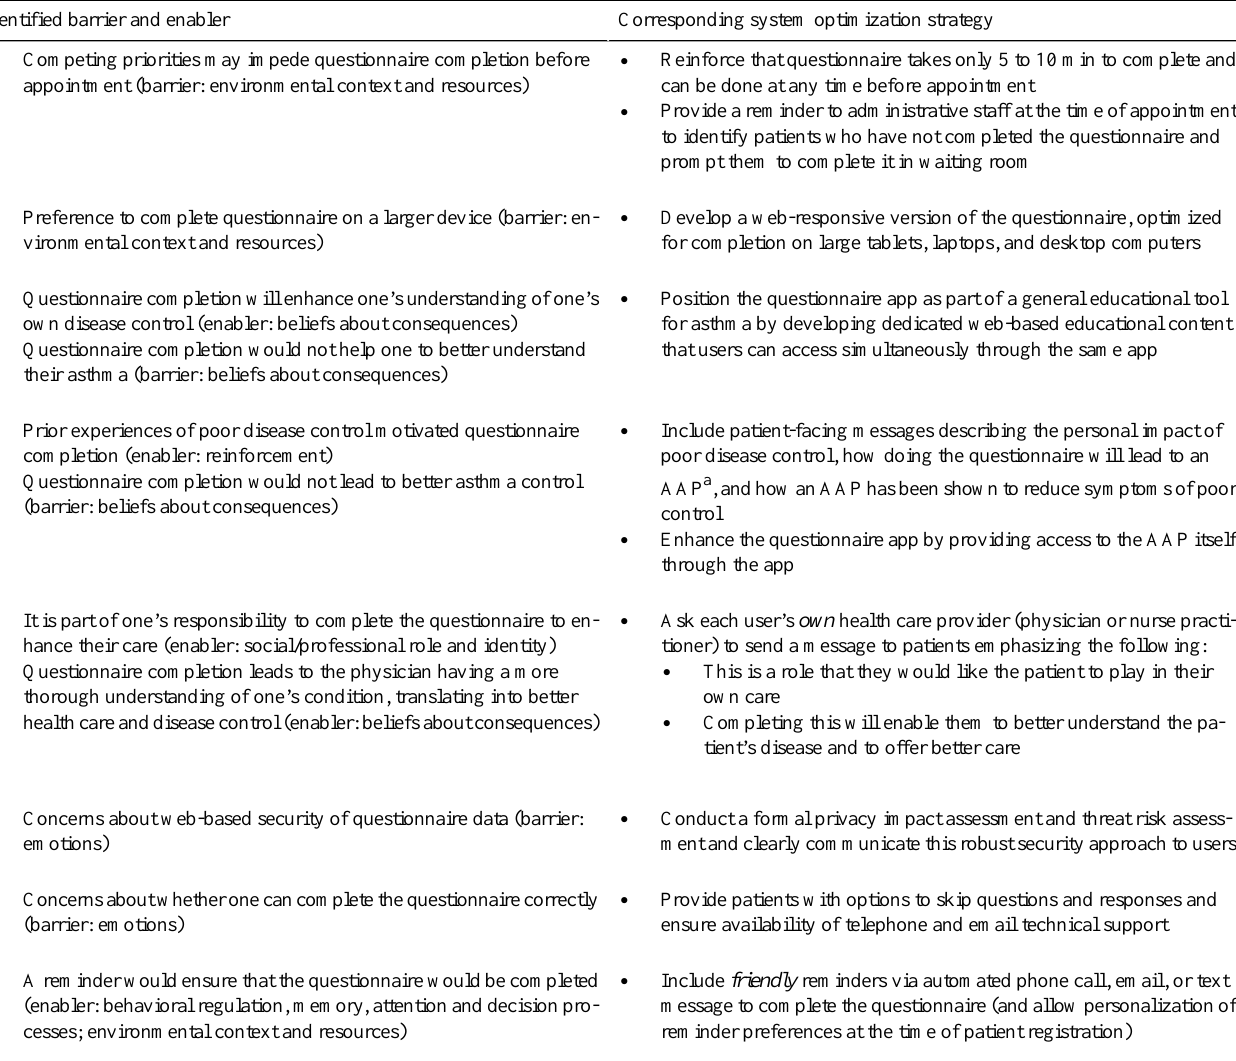
Table 3. Practice implications for uptake and completion of the Electronic Asthma Management System questionnaire based on identified enablers and